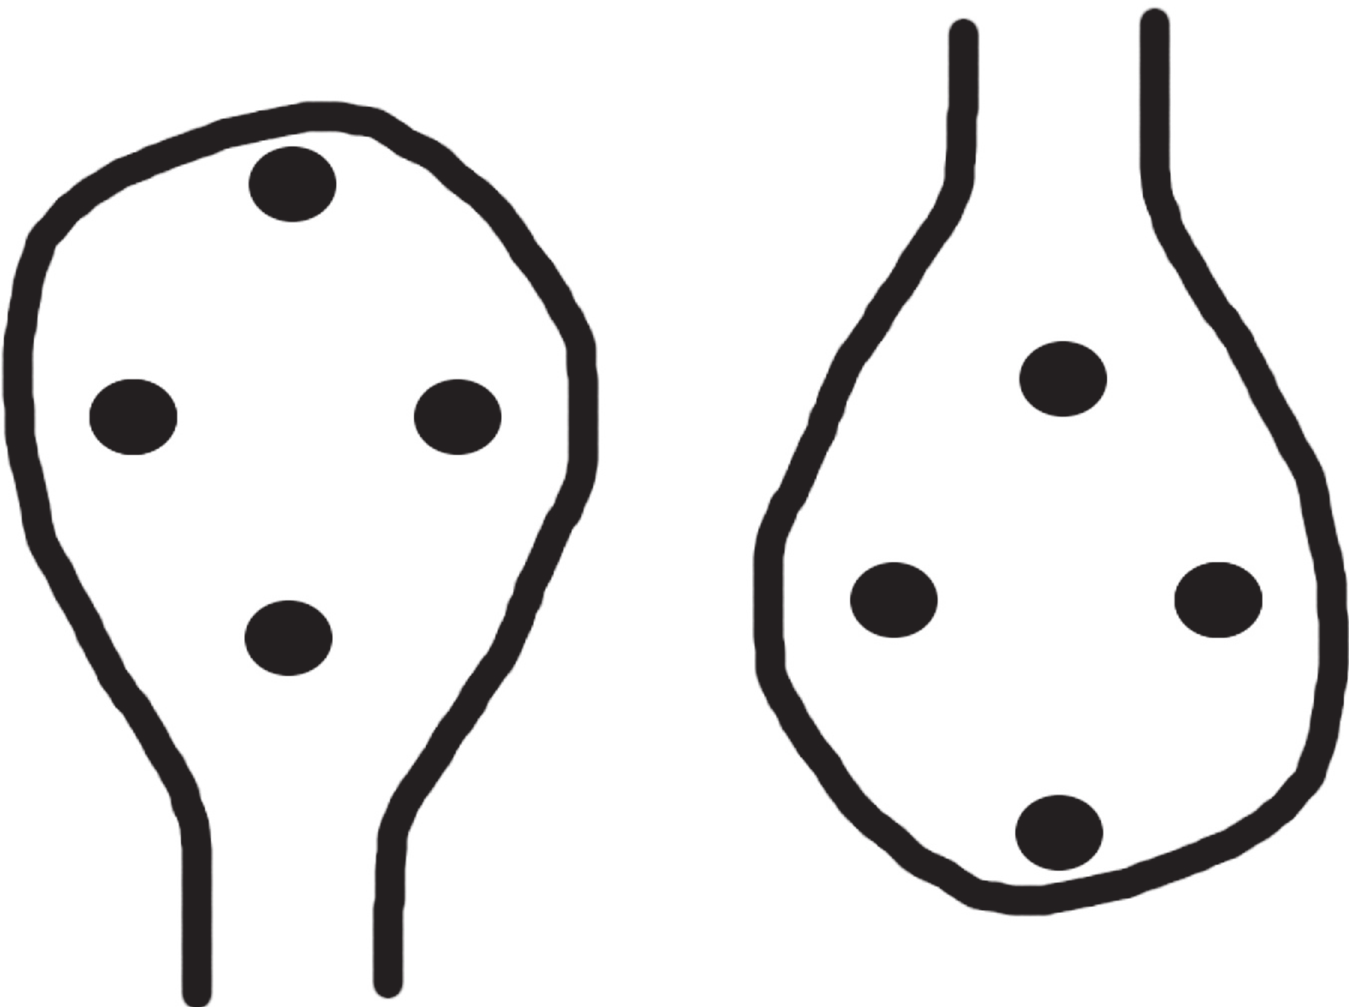
Fig 1. The upright (left) and inverted (left) images presented to infants. Three areas of interest (AOIs) were set to measure the looking time to the blobs. In the upright image, the ‘ top ’ area covers the upper blob, and the ‘ bottom ’ area includes the lower blob. The two areas that cover left and right blobs were virtually concatenated as one AOI and the area is called the ‘ middle ’